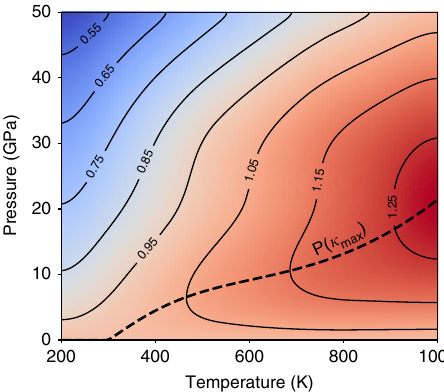
Fig. 5 Non-monotonic pressure dependence of κ (3 + 4) in BSb. Pressure- temperature colormap of κ (3 + 4) of isotopically pure BSb scaled by the corresponding zero-pressure value at each temperature κ ð 3 þ 4 Þ